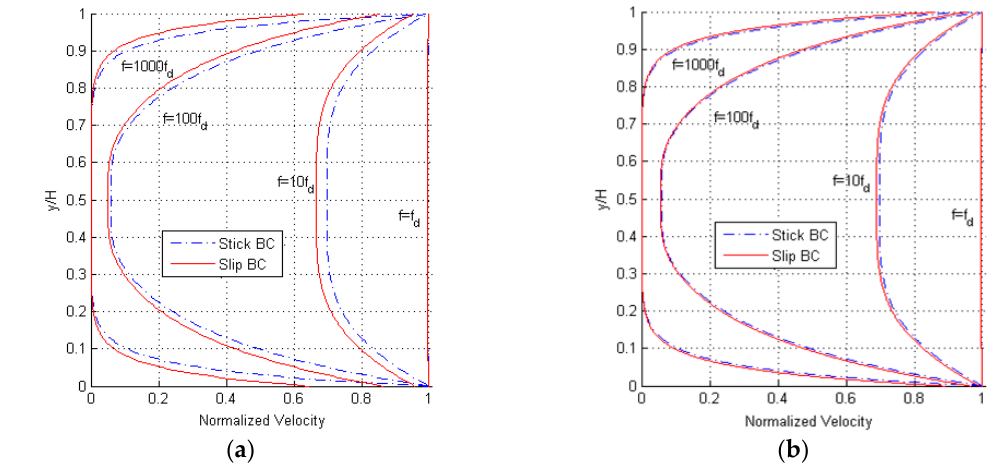
Figure 3. Disengaged solution, ( a ) 𝐻 = 3 μm and ( b ) 𝐻 = 12 μm : maximum amplitude of the velocity profile at varying frequency 𝑓 of oscillation of the two plates, for both stick and slip boundary conditions (BCs).